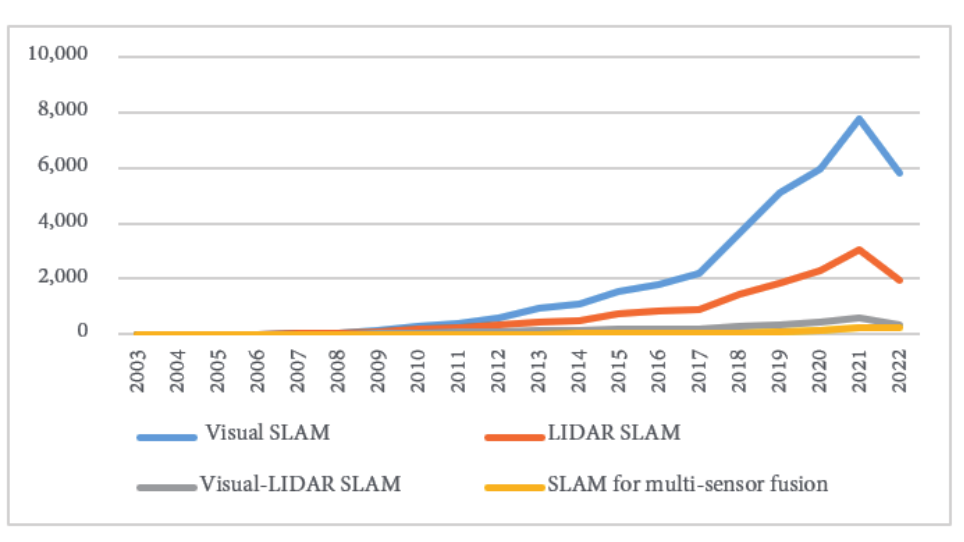
Figure 8. Citations of different methods in the field of SLAM in recent years in the Web of Science.